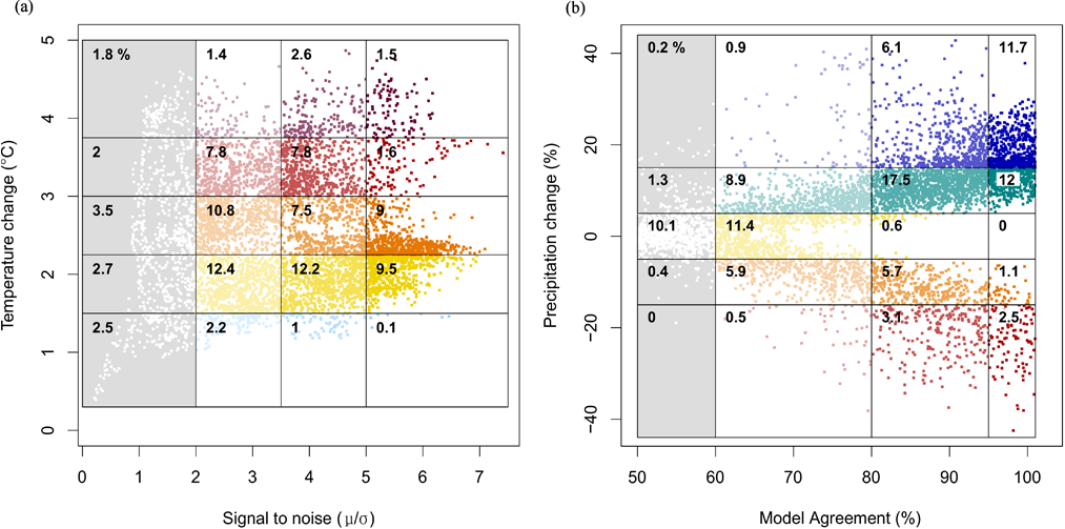
Fig. 9. (a) Scatter plot of temperature data used for Fig. 6e on the x-axis and data used for Fig. 6a on the y-axis, and (b) scatter plot of precipitation data used for Fig. 6d on the x-axis (randomly jittered so it does not appear as a series of straight lines) and data used for Fig. 6b on the